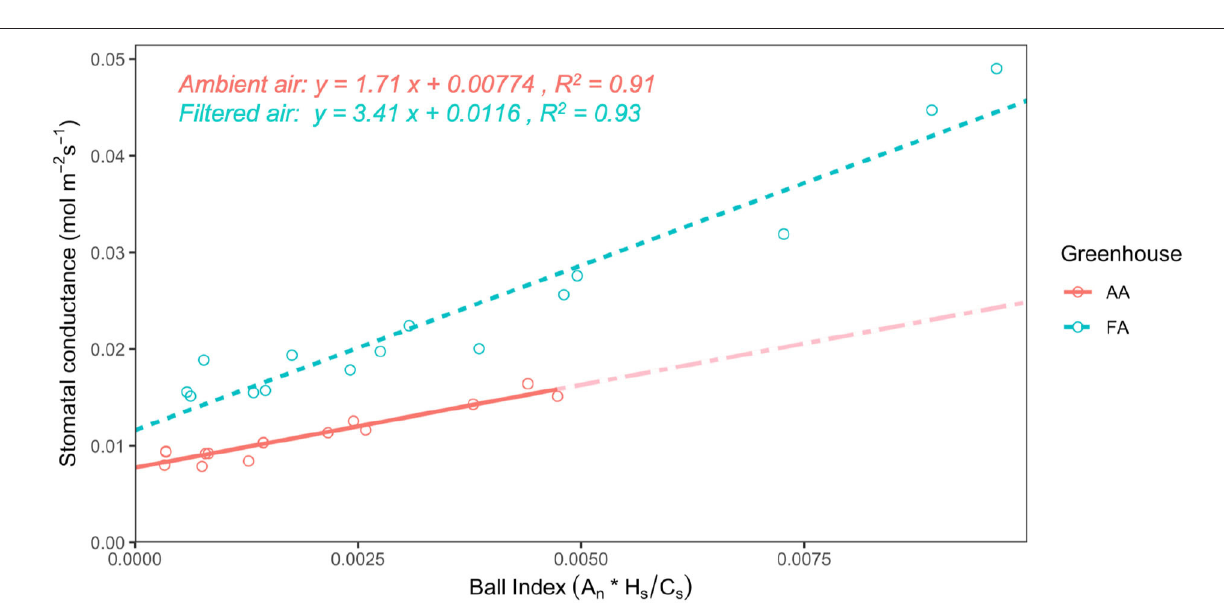
and Ball Index, representing the fitted data calculated from the leaf-scale measurements, where both of the R 2 values are higher than 0.90. The slope of the linear regression (g 1 ) for AA is